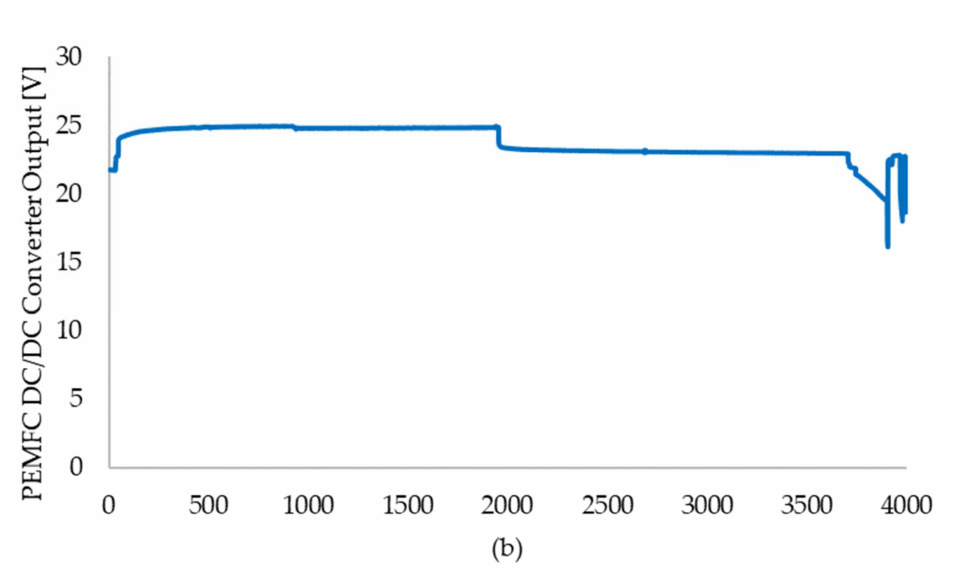
Figure 14. ( a ) Start-up battery SoC levels; ( b ) PEMFC’s DC/DC converter output voltages.